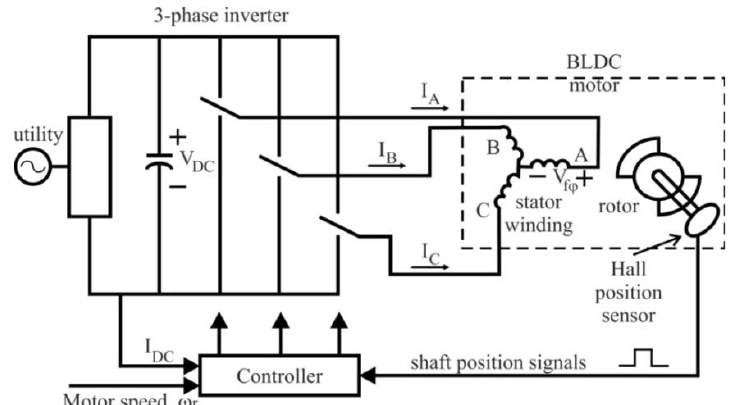
Figure 5. Electronically commutated BLDC motor drive